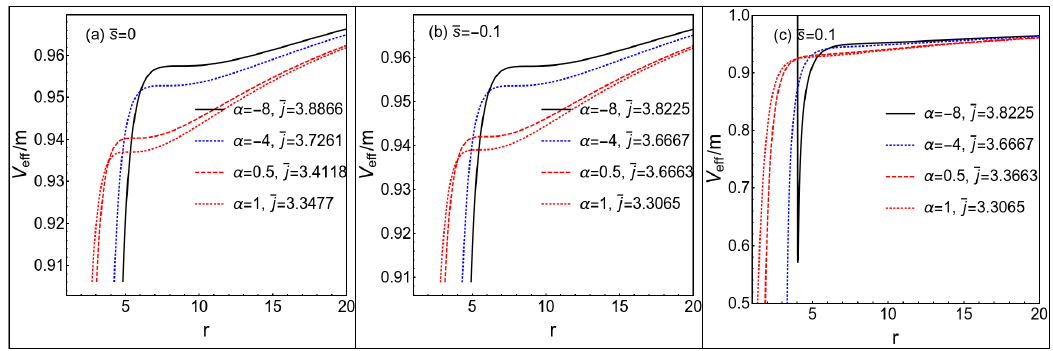
Figure 1. The effective potential for a spinning test particle in the four-dimensional Einstein–Gauss–Bonnet (EGB) black hole background. The parameters are set as M = 1 and m =